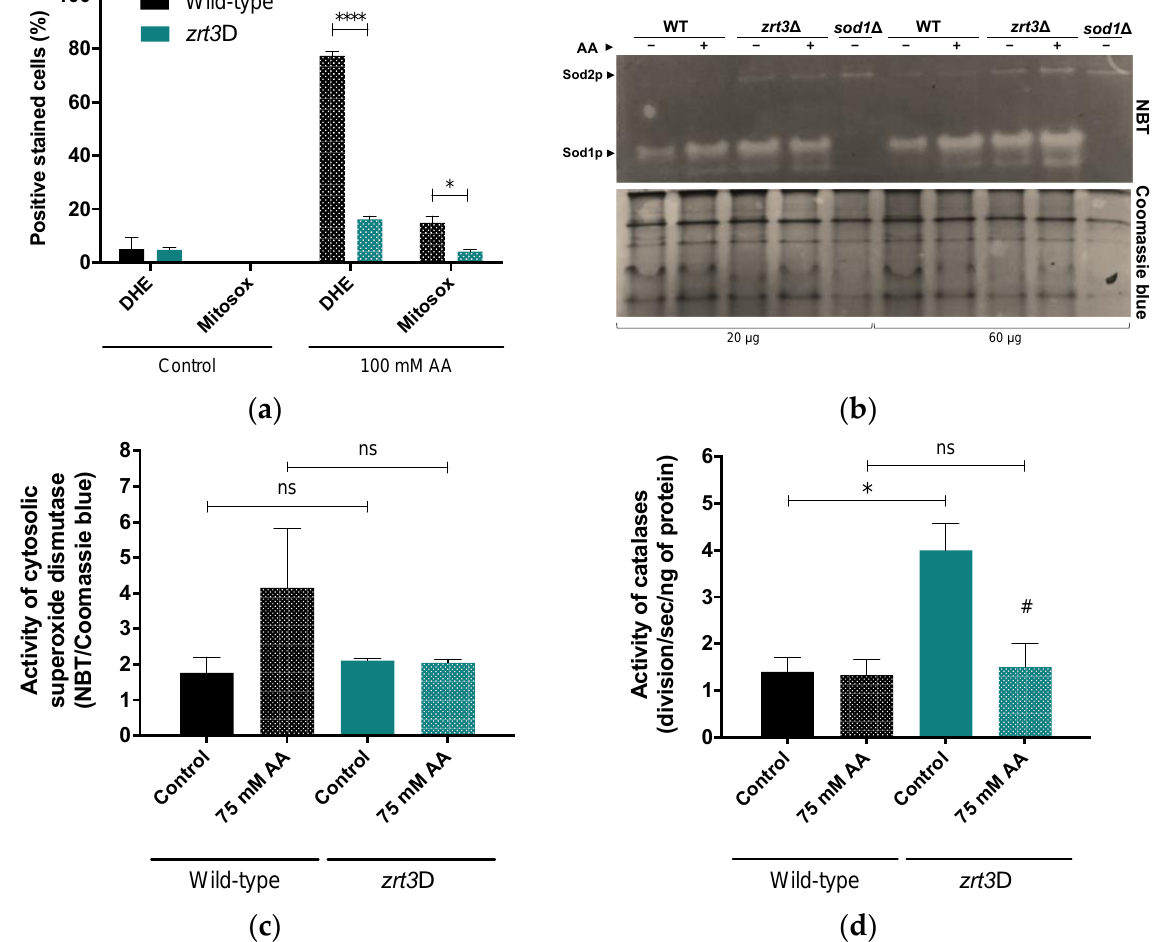
Figure 2. The effect of AA on superoxide anion accumulation and Sod1 and catalase enzymatic activities in wild-type and zrt3 ∆ cells. ( a ) Cellular and mitochondrial superoxide anion accumulation in S. cerevisiae BY4741 wild-type and zrt3 Δ strains 60 min after incubation with AA (100 mM), pH 3.0 or in the absence of AA. Values represent the percentage of cells with positive DHE and Mitosox staining and are the mean ± SEM ( n = 2). Statistical analysis was performed by two-way ANOVA. * p < 0.05, **** p < 0.0001 in comparison with the wild-type strain. ( b ) To evaluate Sod1 activity in WT and zrt3 ∆ mutant 60 min after incubation with AA (75 mM) or in the absence of AA, protein extracts were run on native polyacrylamide gels (15%) and stained with NBT and Coomassie blue. Two different concentrations of each condition (20 and 60 µ g) are shown. As a Sod1 control, the sod1 ∆ mutant was used. Representative gels of these assays are shown. ( c ) To measure enzymatic activity, the intensity of gel bands from ( b ) was quantified using Image J software. Values are the mean ± SEM ( n = 3). Statistical analysis was performed by one-way ANOVA. Non-significant values are represented as ns. ( d ) Determination of activity of catalases was estimated by measuring oxygen consumption with a Clark electrode. Activity of catalases was evaluated in 3 replicates of the same sample using 0.75 mM H 2 O 2 . Values are the mean ± SEM ( n = 3). Statistical analysis was performed by one-way ANOVA * p < 0.05, in comparison with the wild-type strain. # p < 0.05 in comparison with the control.